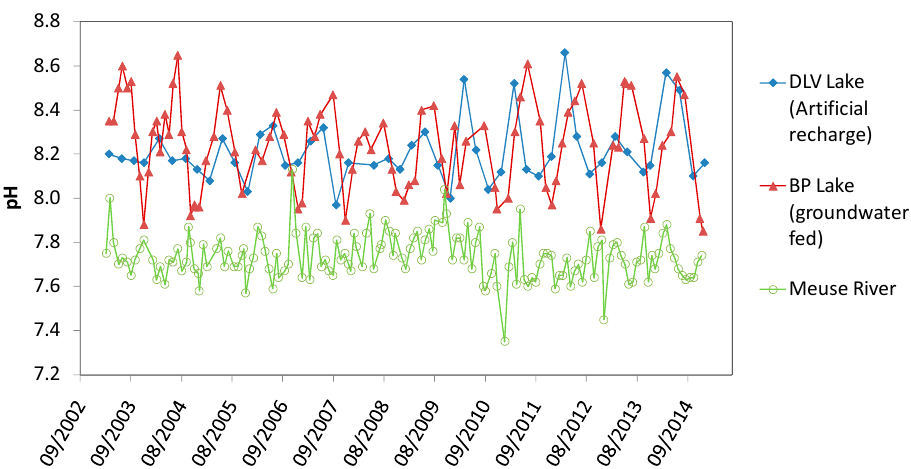
Figure 7. pH of gravel pit lake with artificial recharge (DLV Lake), groundwater fed only (BP Lake) and River Meuse water from 2001 to 2014.